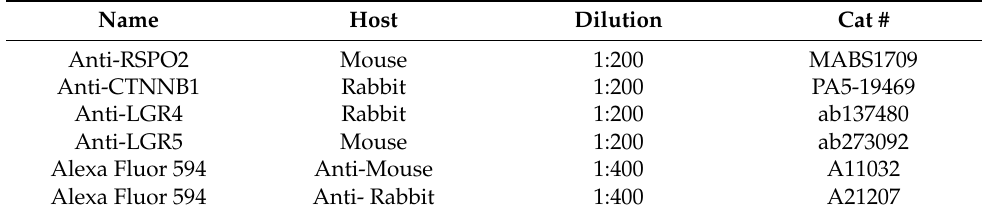
Table 1. Antibodies used for immunofluorescence